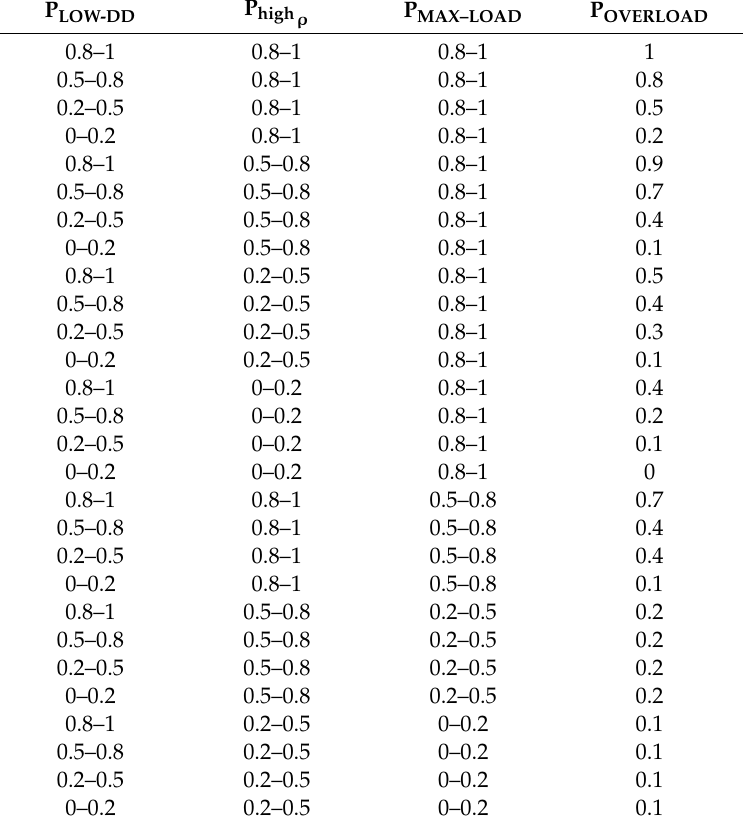
Table 8. Probabilities for overload risk.